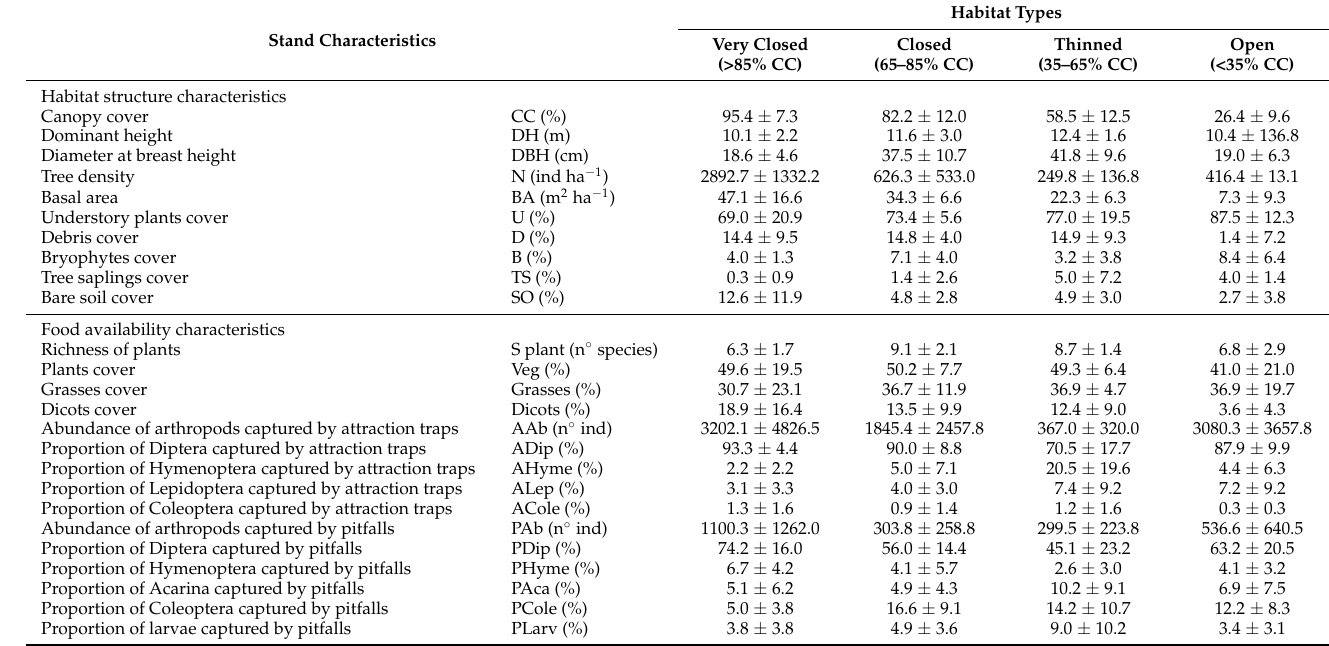
Table A1. Mean and standard deviation values of stand characteristics (habitat structure and food availability) by habitat types analyzed for Nothofagus antarctica forests in Tierra del Fuego